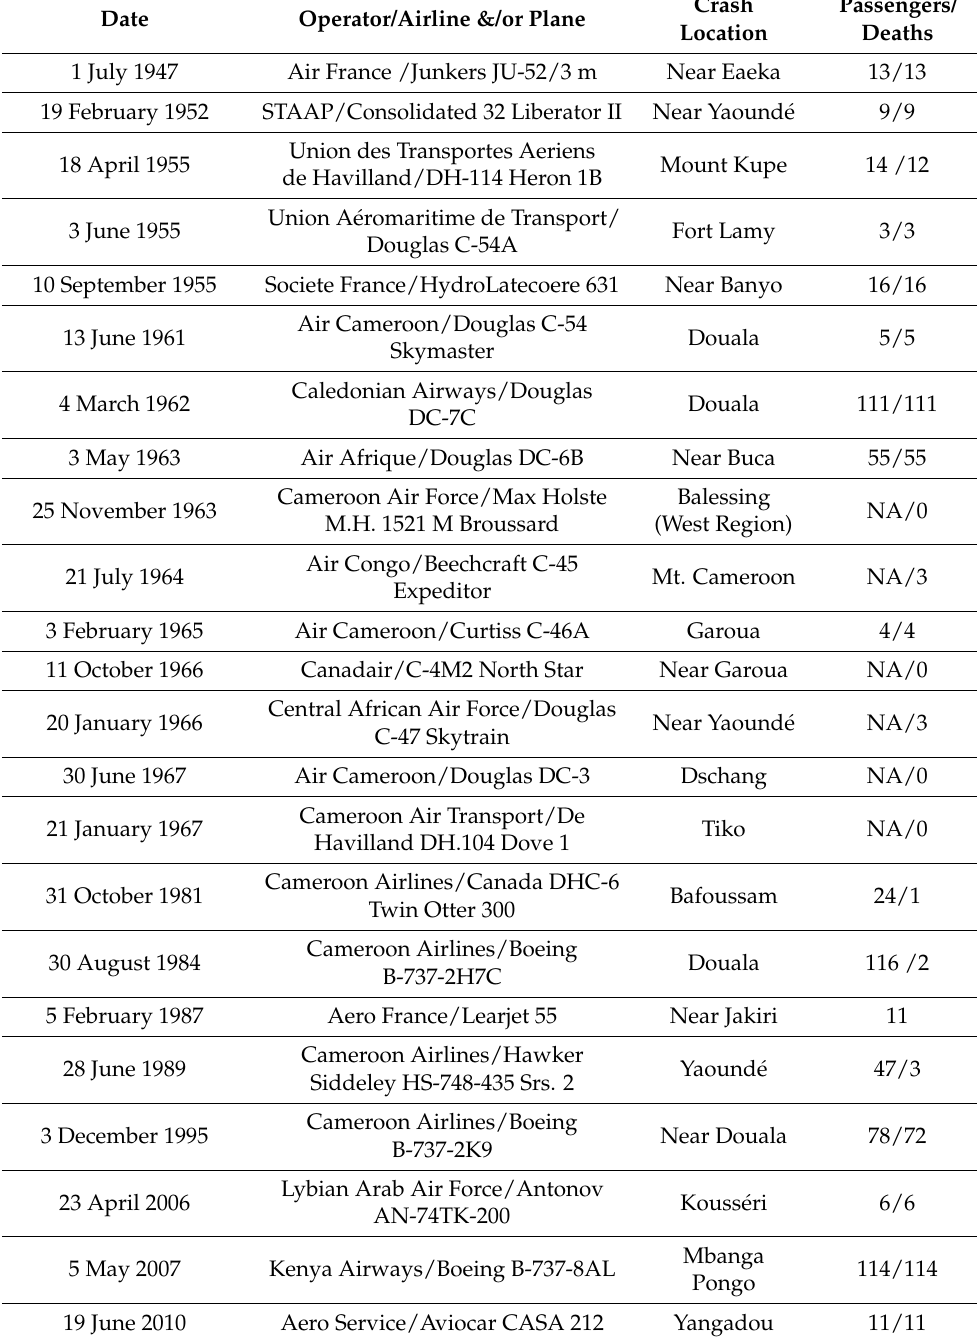
Table 4. Airplane crashes and accidents in Cameroon from 1947 to